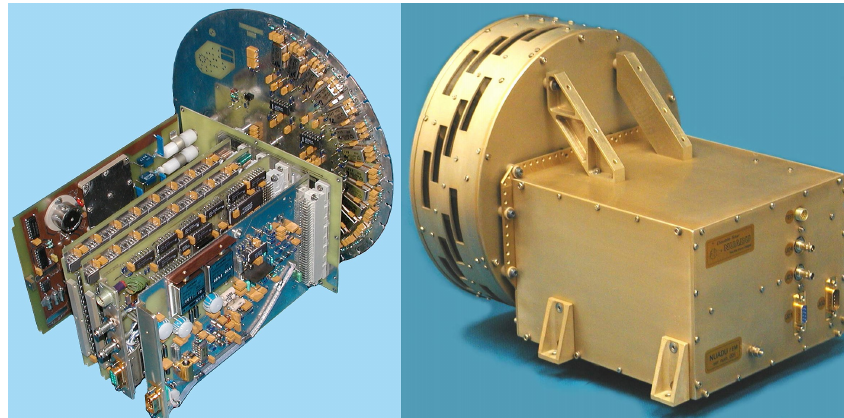
Fig. 10. (left) view of the electronic boards that are mounted inside the electronic box; (right) external view of the electronic box.